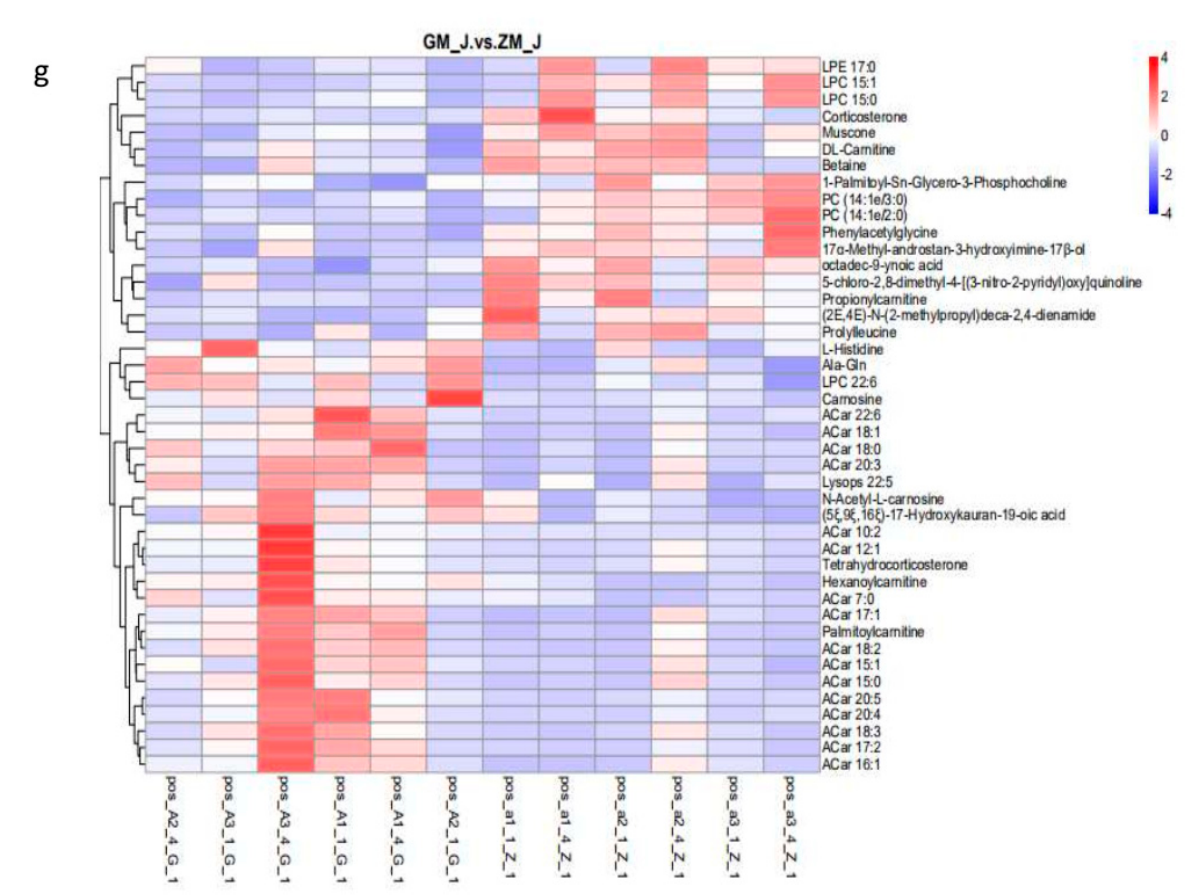
Figure 1. Skeletal muscle metabolite score and permutation test of rabbits in normal and high-fat diet groups. ( a , b ), PCA score graph between normal and high-fat diet groups; ( c , d ), permutation test from PLS-DA models; ( e , f ), volcano of metabolites with significant differences between normal and the high-fat diet groups; ( g ) is the clustering heat map of differential metabolites between normal and the high-fat diet groups. Note: ESI+: cationic mode; ESI-: Anion mode; GM: High fat group; ZM: Normal group. Table 1. Composition and nutrient content of the standard normal diet (SND) and the high-fat diet (HFD) Table 2. Potential skeletal muscle biomarkers based on UPLC-Q-TOF/MS in rabbits fed a high-fat diet.